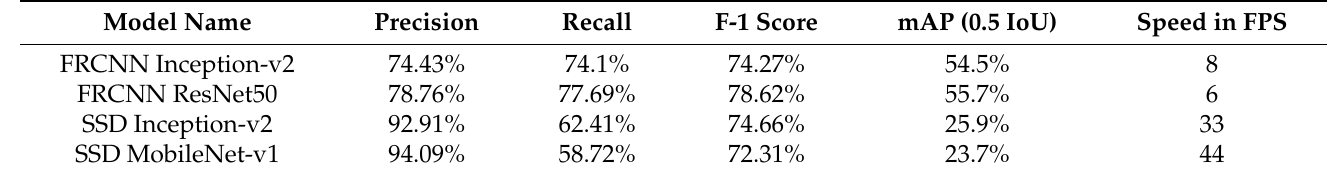
Table 4. The performance of various object detection models for AAU PD T test